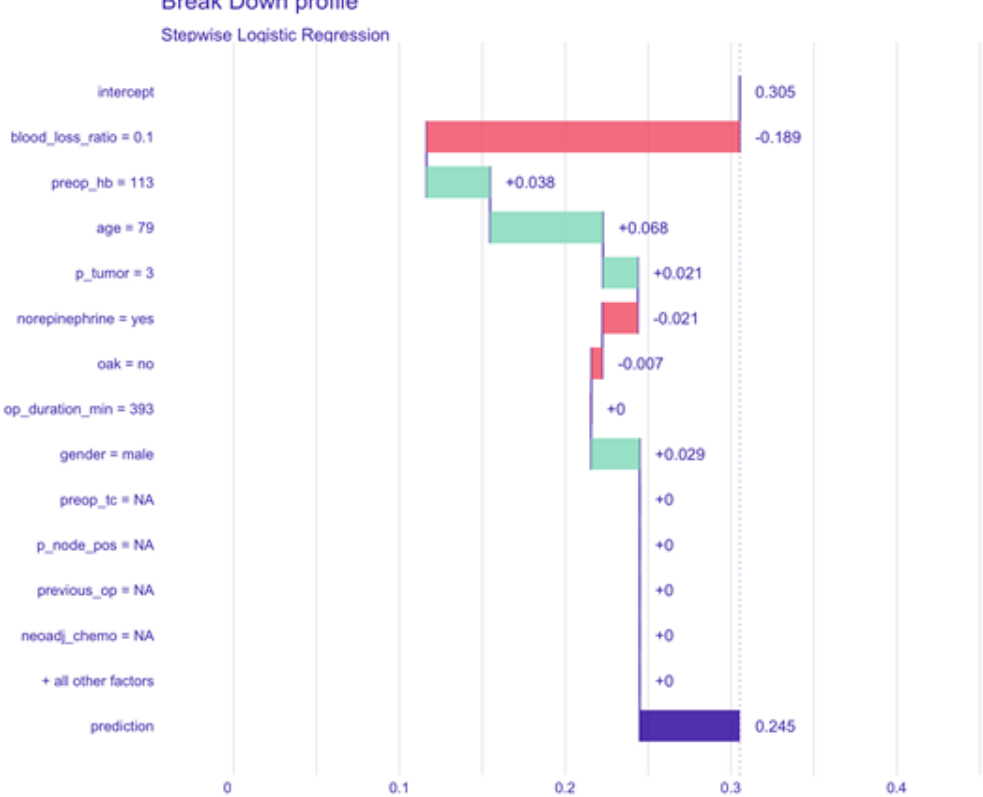
Figure A6. Older male patient with lower hemoglobin levels and lower blood loss (p trans = 24.5%).